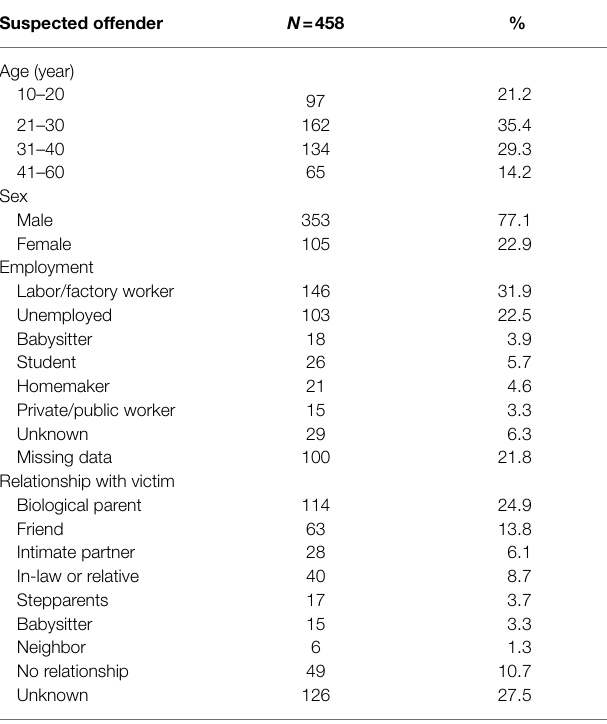
TABLE 4 | Background of child homicide offenders in Malaysia from January 2010 to June 2021. Suspected